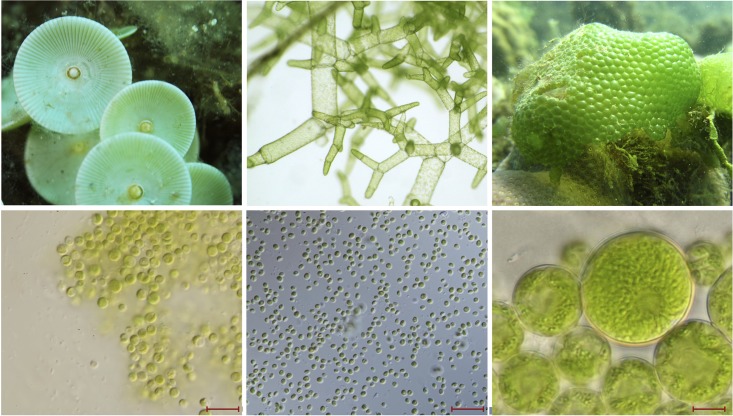
Images of macro- and micro-green algae. (Top) Left to right, large ulvophyte green algae, which are visible by the naked eye: Acetabularia sp. (image by Albert Kok), Boodlea composita (image by Frederik Leliaert), and Dictyosphaeria cavernosa (image by Frederik Leliaert). (Bottom) Left to right, images from Veselá et al. (2011): picoprasinophyte Picosystis salinarum (scale bar 10 μm), picoplanktonic trebouxiophyte Choricystis sp. (scale bar 20 μm), and trebouxiophyte Dictyochloropsis splendida (scale bar 10 μm).